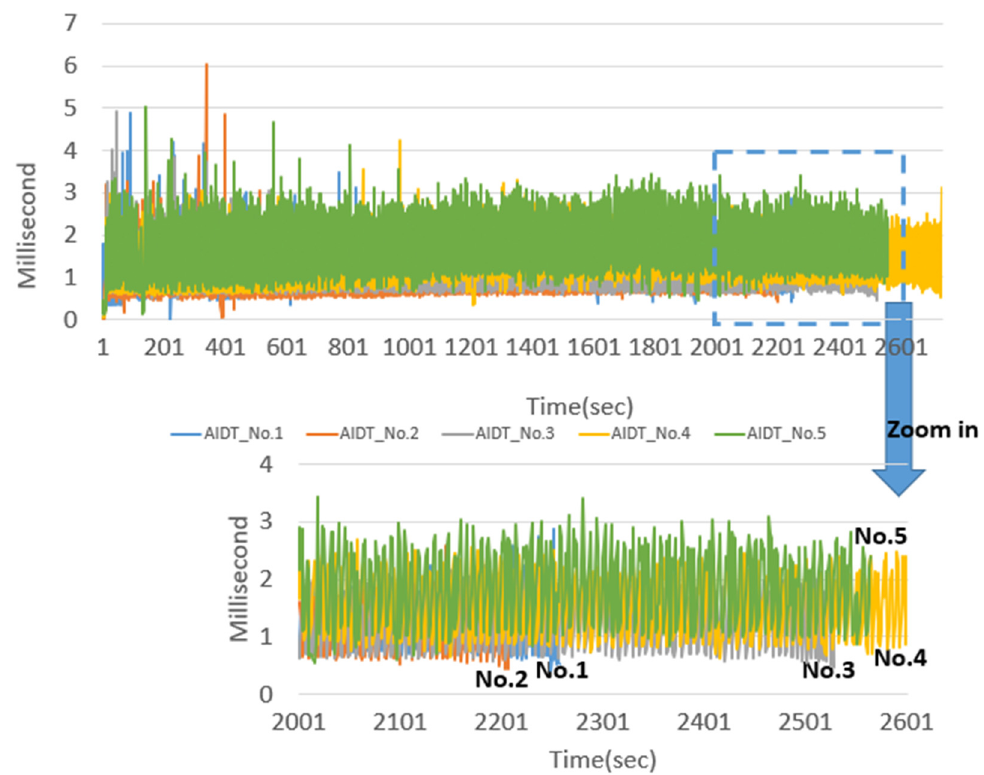
Figure 16. Average ignition delay time.